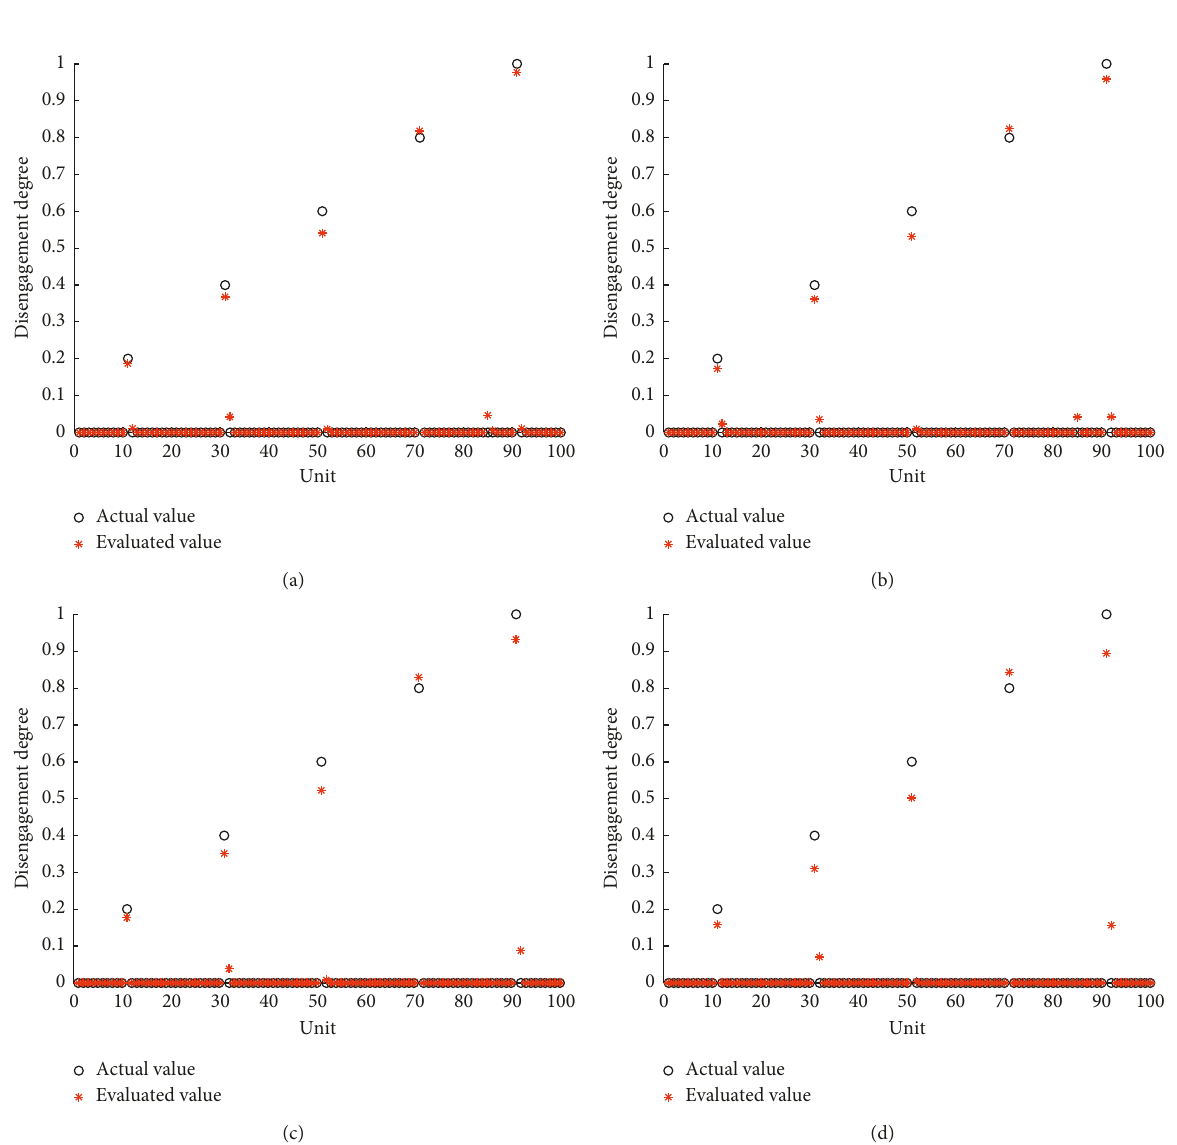
Figure 10: Estimation results of CMDEA under different noise levels: (a) 1% signal noise; (b) 3% signal noise; (c) 5% signal noise; (d) 10% signal